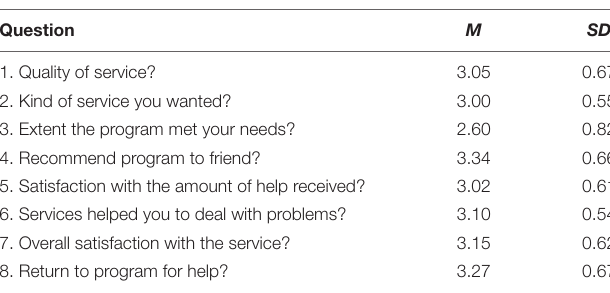
TABLE 9 | Client Satisfaction Questionnaire ( n =